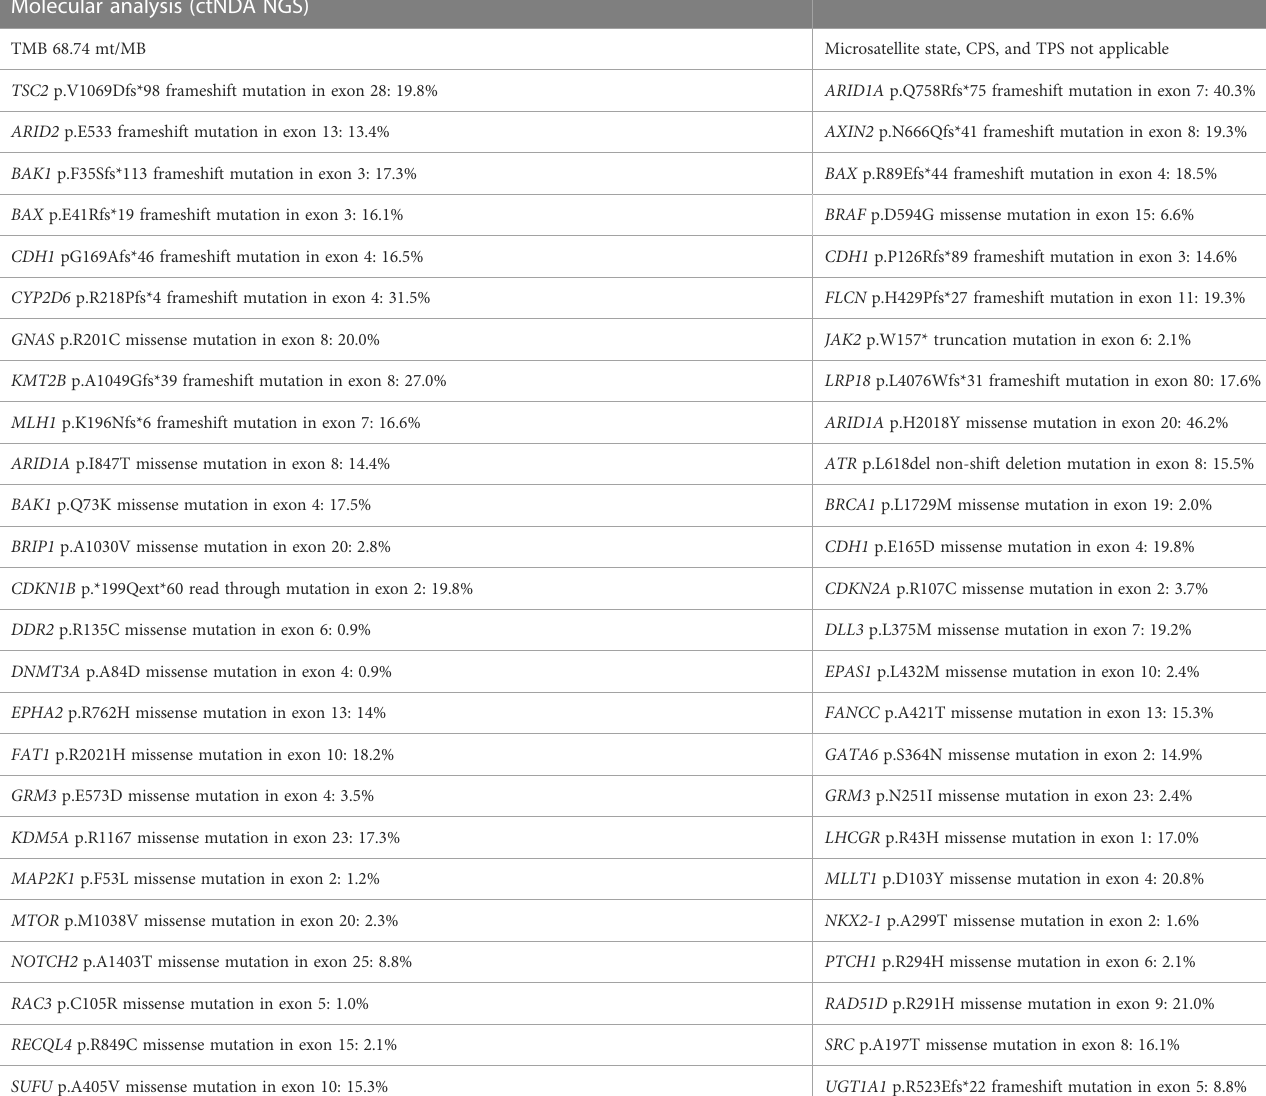
TABLE 1 Summary of molecular